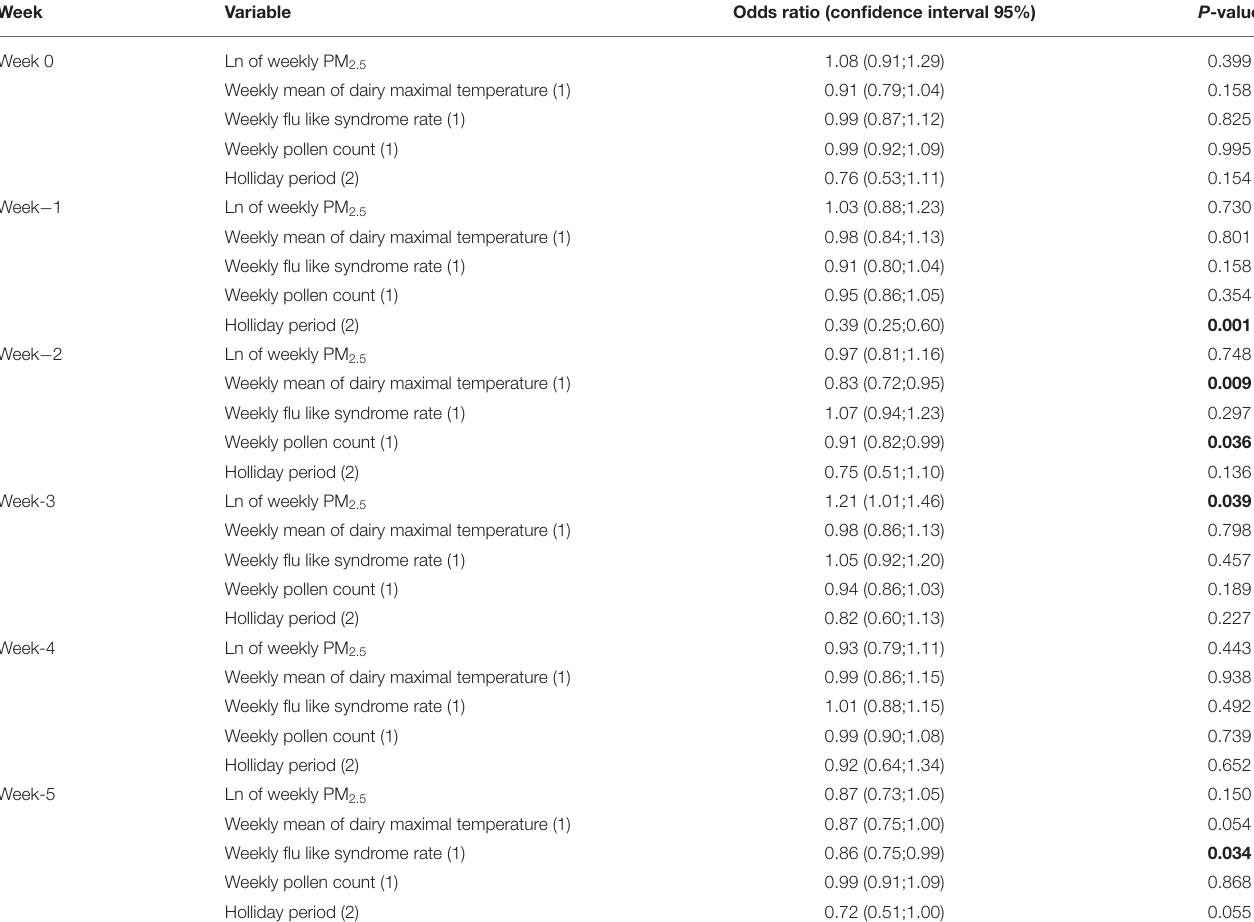
TABLE 2 | Impact of PM 2.5 weekly concentration on multiple sclerosis relapse, multivariate analysis. Week Variable Odds ratio (confidence interval